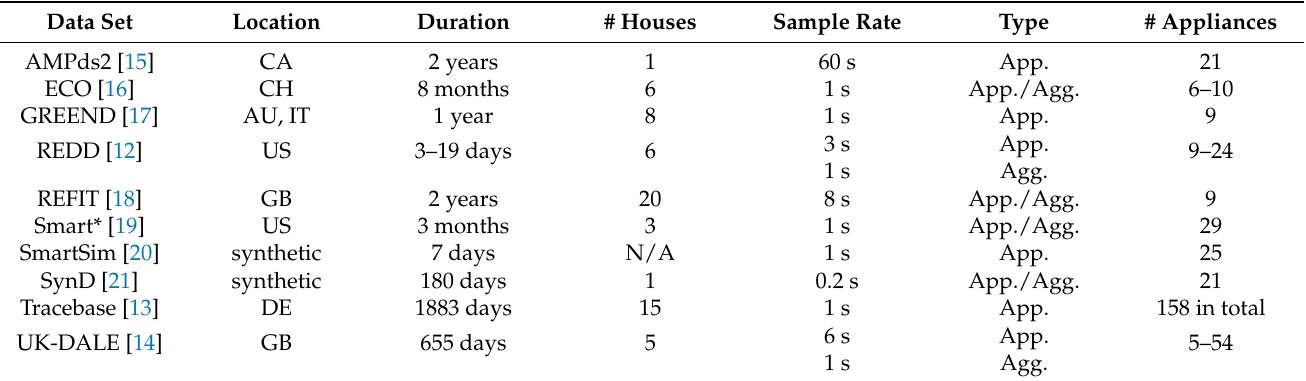
Table 1. Accessible electricity consumption datasets.